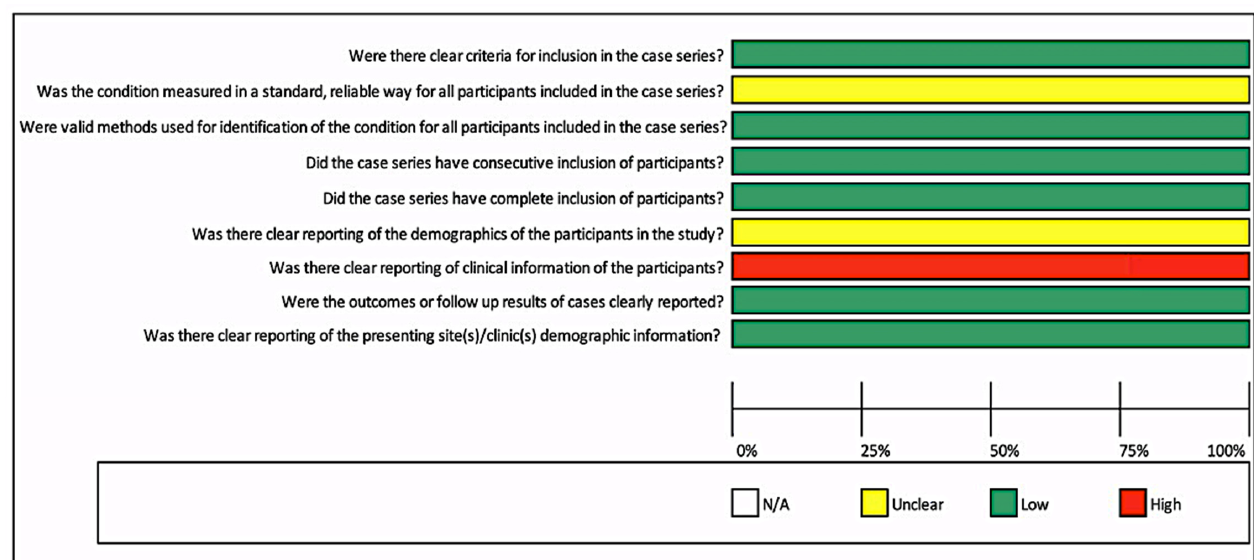
Figure 2. Risk of bias across included studies for case reports.